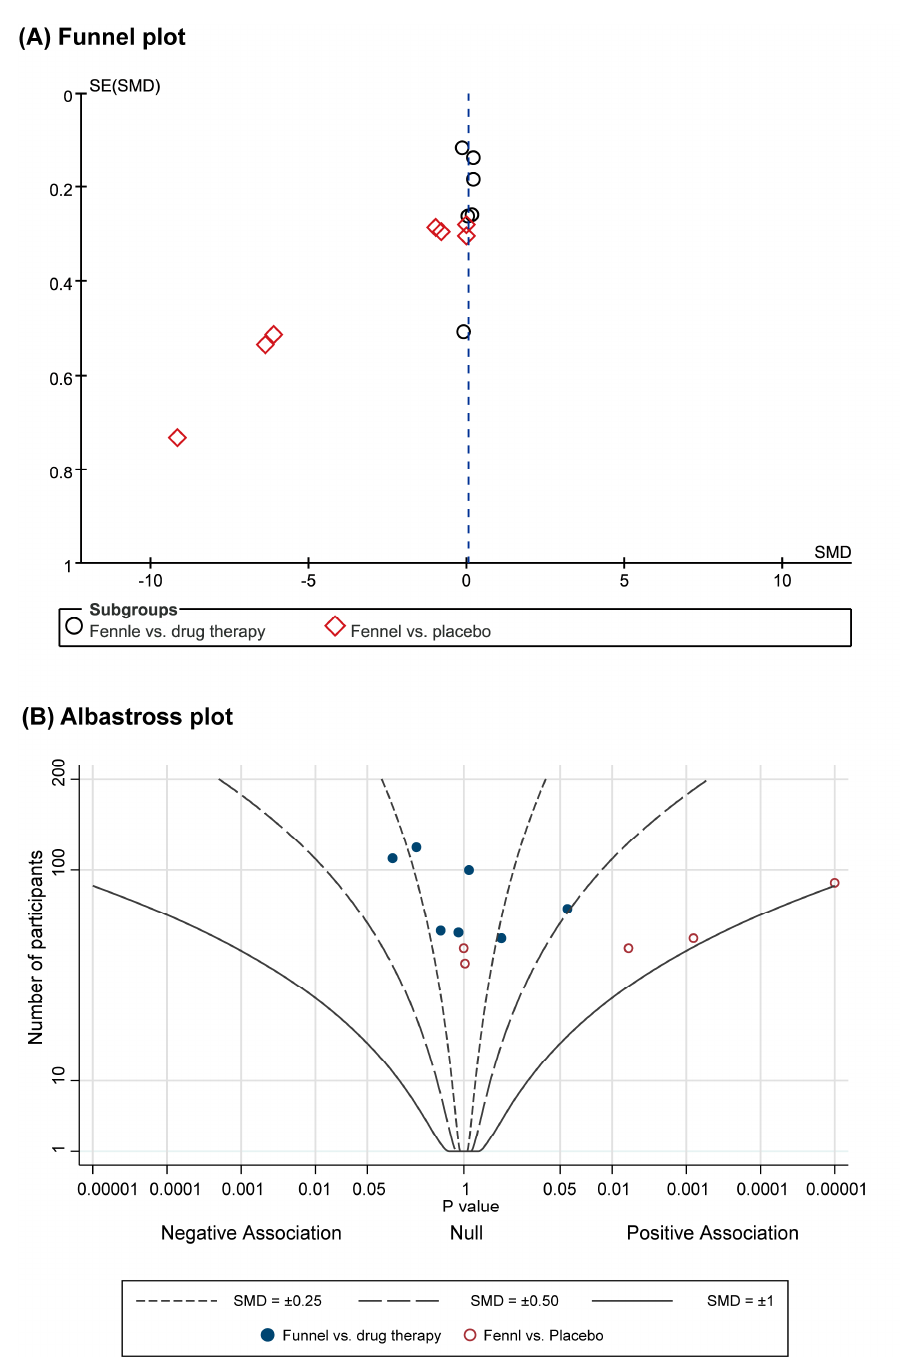
Figure 4. ( A ) Funnel plot for fennel for managing pain; ( B ) Albatross plot. SE: standard err; SMD: standard mean difference.